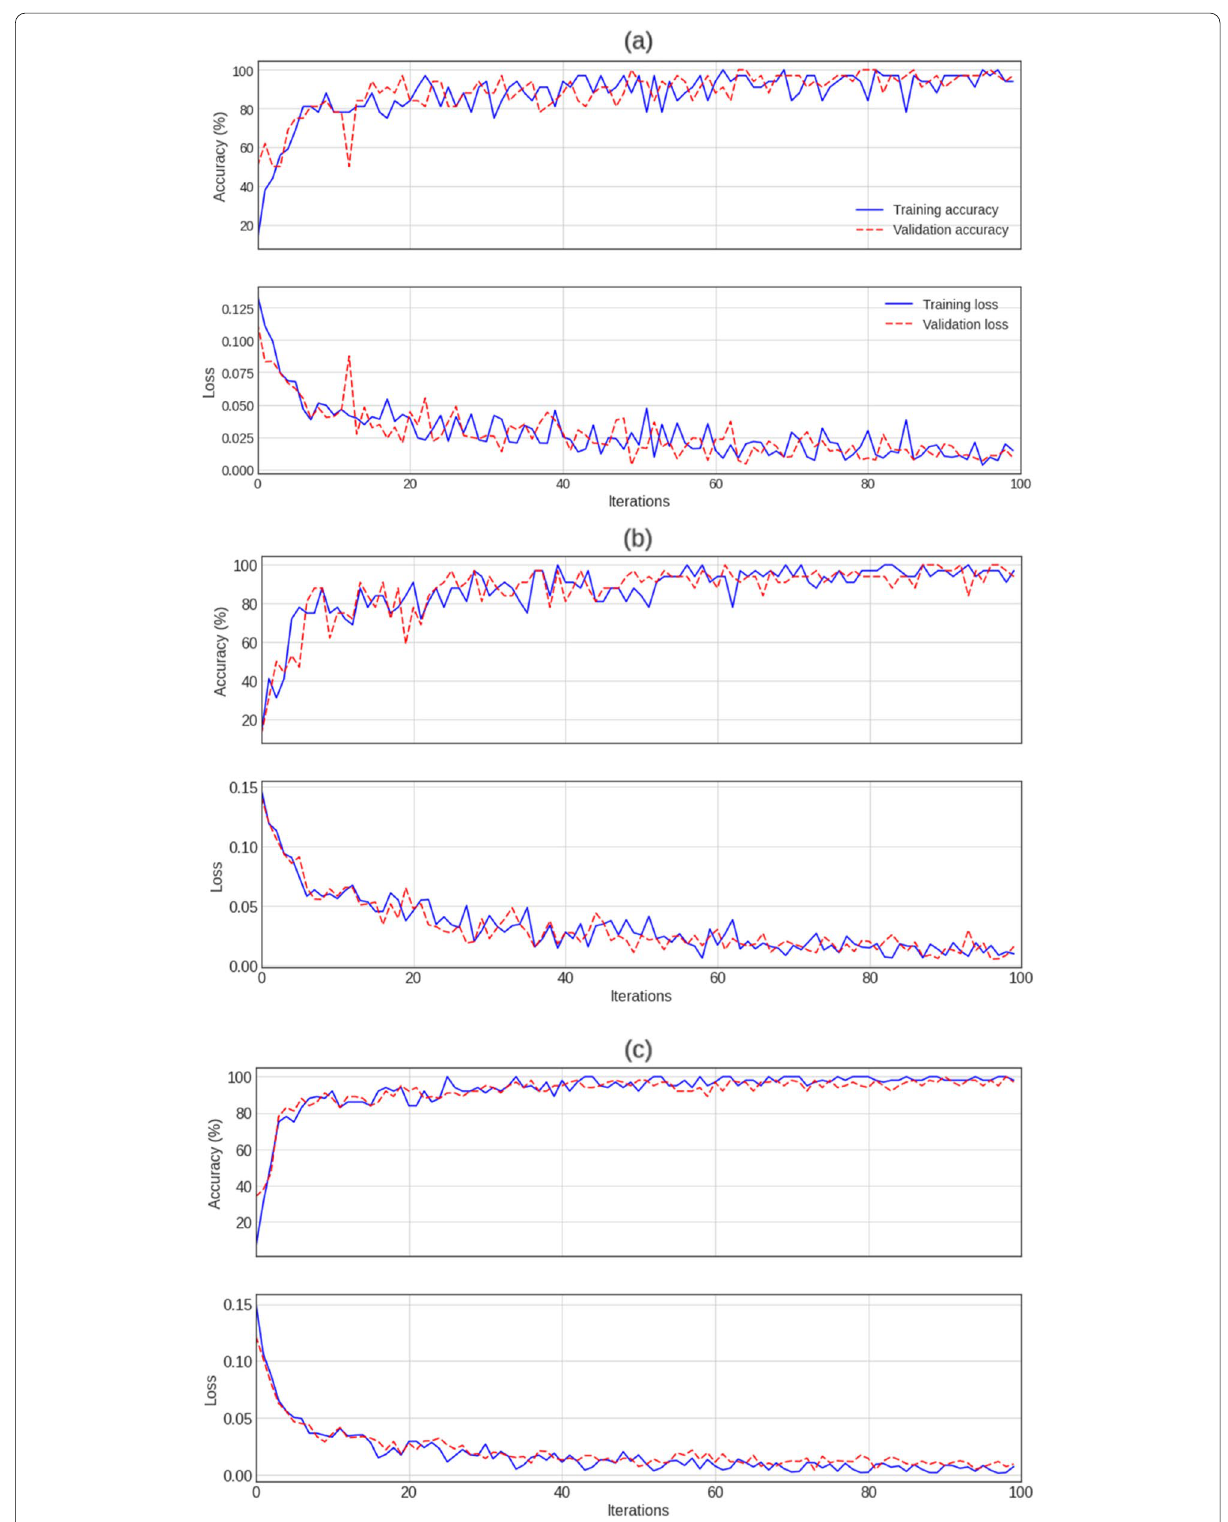
Fig. 8 Results of the proposed training using the optimally-tuned model: a C1, b C2 and c